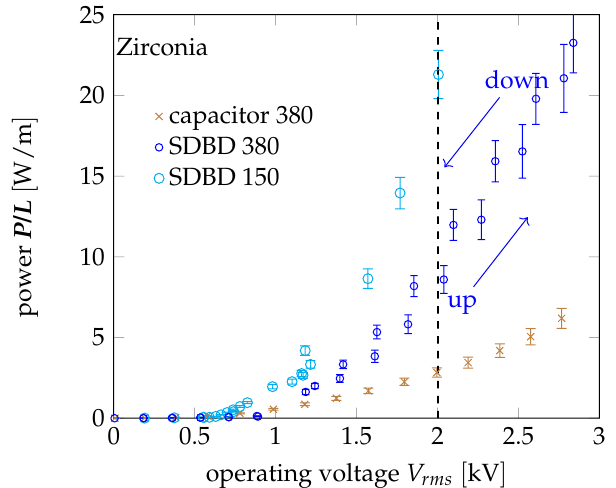
icing experiment.